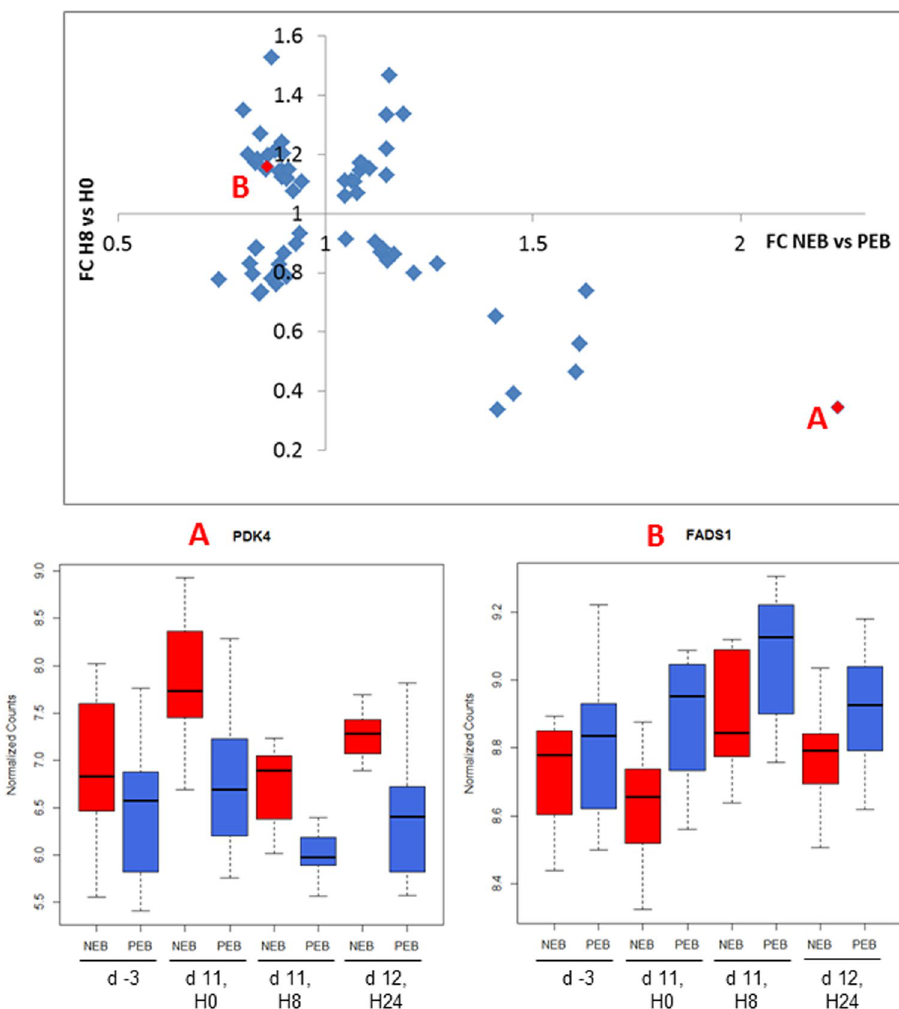
change of the DEG (q-value < 0.05) in early response to inflammatory challenge. Boxplots show